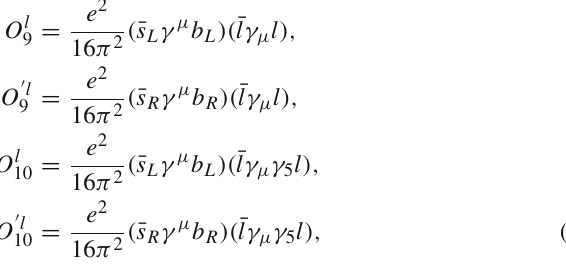
Table 2 Input parameters, their ranges, and prior distributions for the 10 scans we run in this study Parameter Range Prior